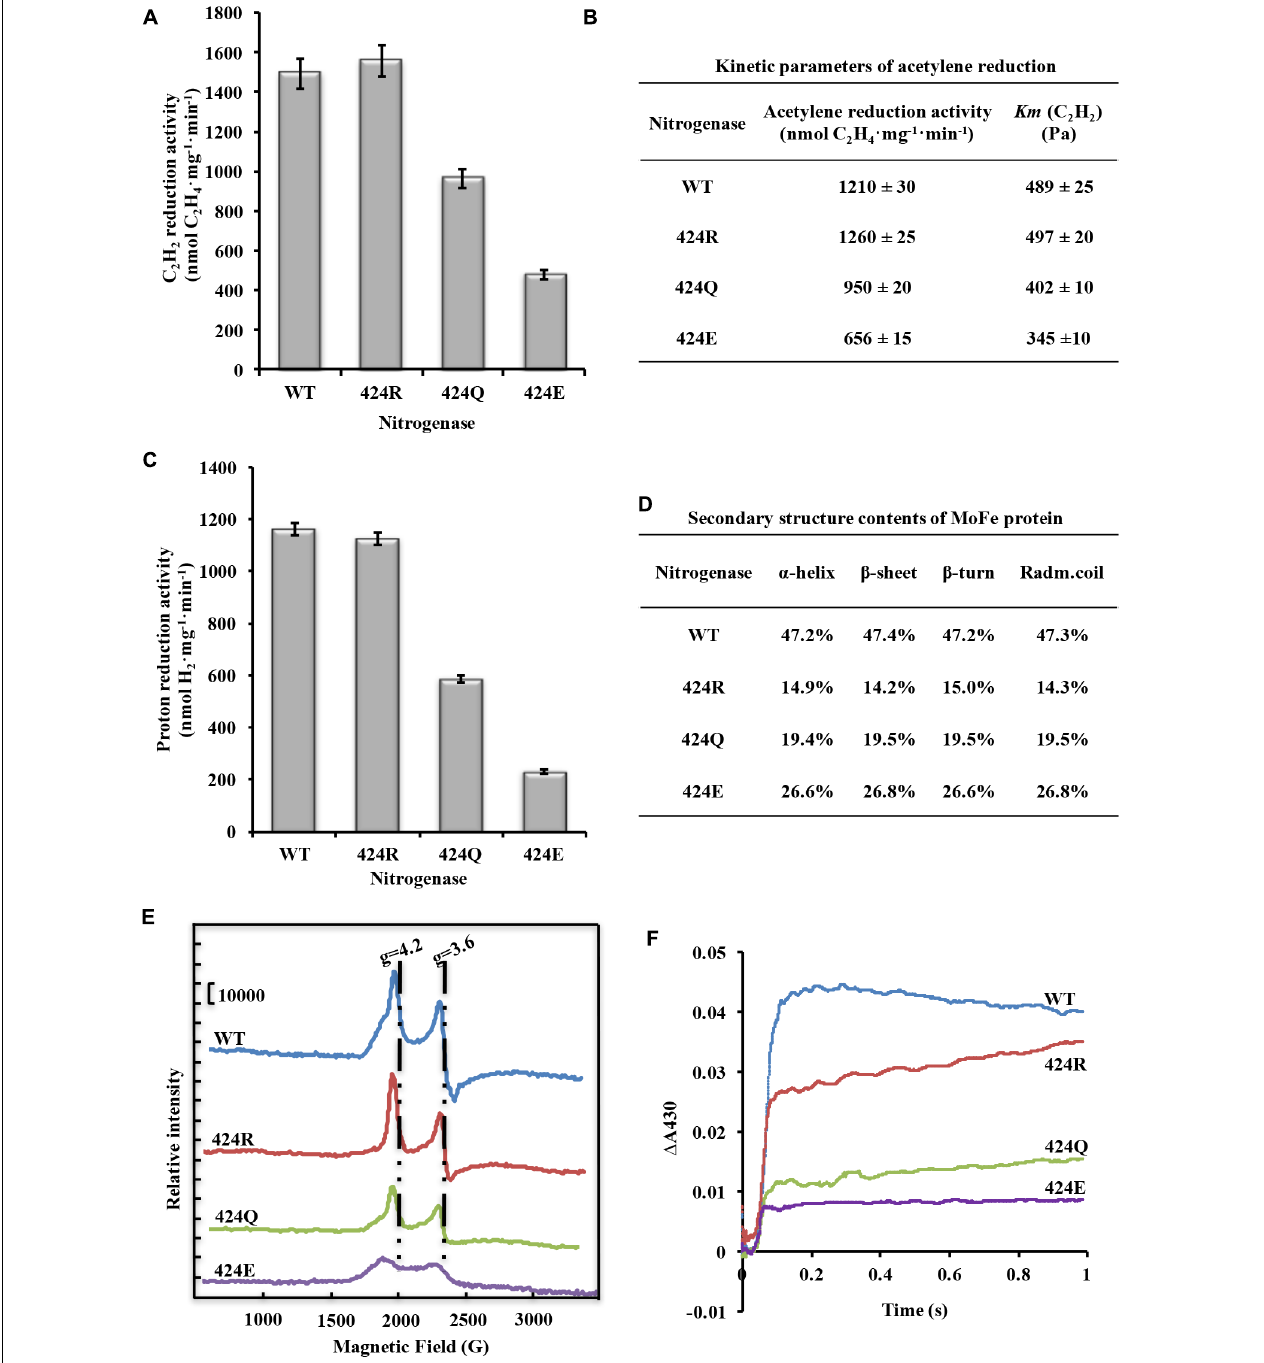
FIGURE 4 | Analysis of nitrogenase properties. (A) Acetylene reduction activity of nitrogenase. (B) Kinetic parameters of acetylene reduction. (C) Proton reduction activity of nitrogenase. (D) Secondary structure parameters of WT and altered MoFe proteins. Assay was conducted at room temperature. (E) FeMoco content measurement by EPR spectroscopy. Spectrometer settings: power 101 mW; temperature 5 K; microwave frequency 9.38 GHz; amplitude 10 G. (F) Electron transfer rate analysis by stopped-flow spectroscopy. Spectrometer settings: wavelength 430 nm, timebase 3 s/10,000 points, bandwidth 0.5 mm; temperature 20 ◦ C.